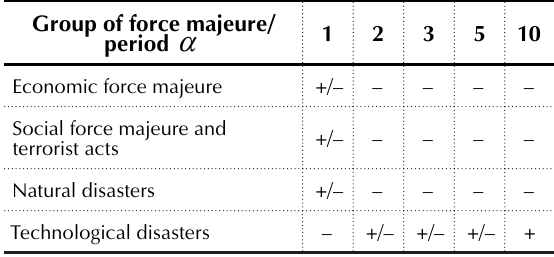
Table 18. Overall results for Hypothesis 1*